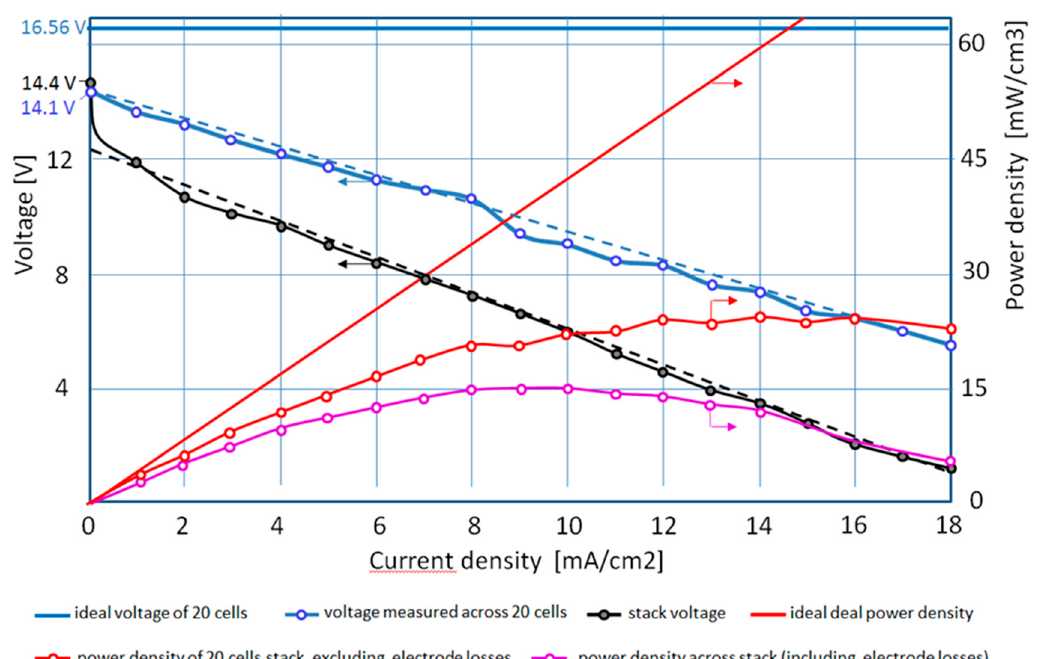
Figure 7. Discharge voltages and net discharge power densities of the 20-cell stack with 1 M acid/base at 25 °C, plotted over discharge current density.